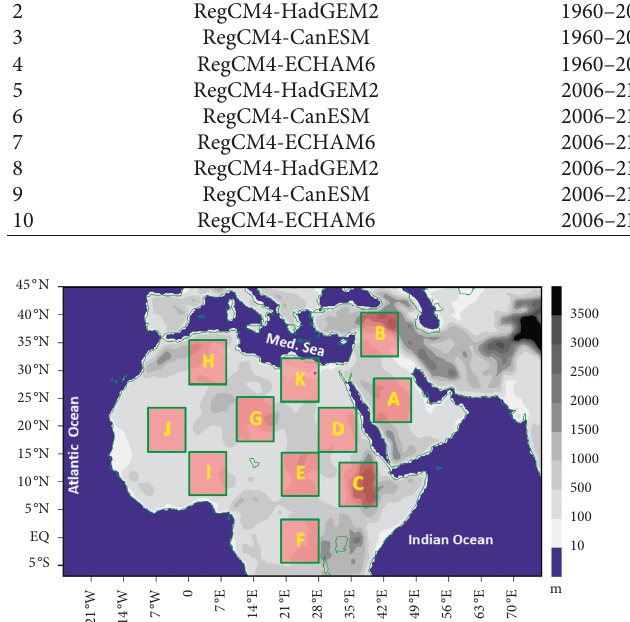
Figure 1: Analysis domain with 11 subdomains. The subdomain A is over the Arabian Peninsula which is focused in this analysis for detail study. The elevation (in meters) indicates the topography of the